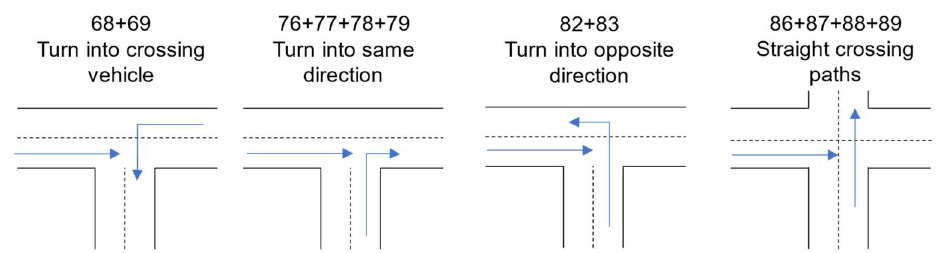
Figure 3. Schematic illustration of the crossing scenarios according to [16].